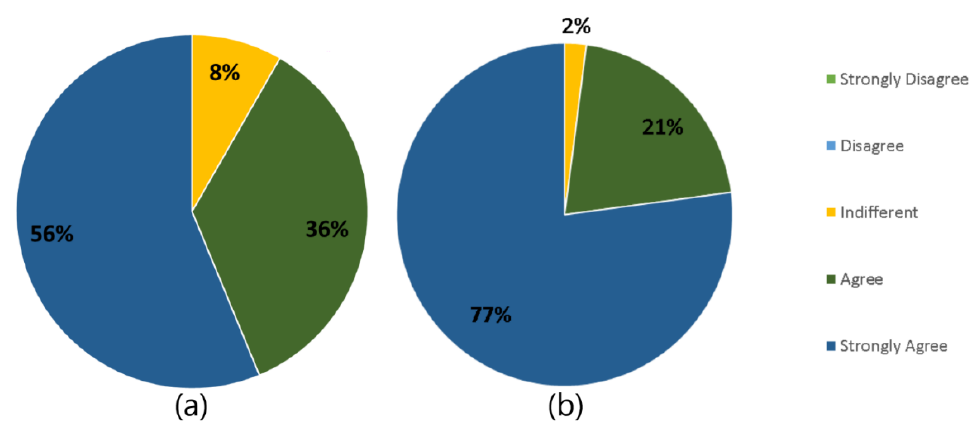
Figure 11. Total utility ( a ) and total ease ( b ) perceived by users.